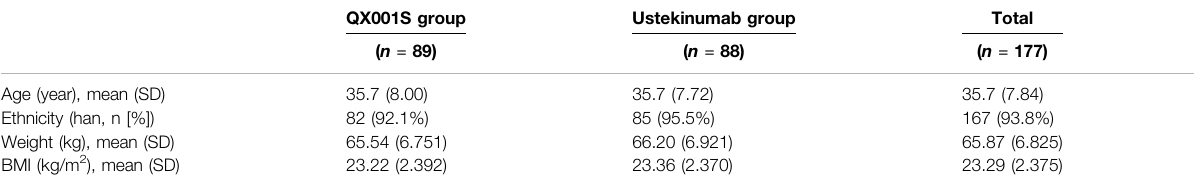
TABLE 1 | Demographic and baseline characteristics.